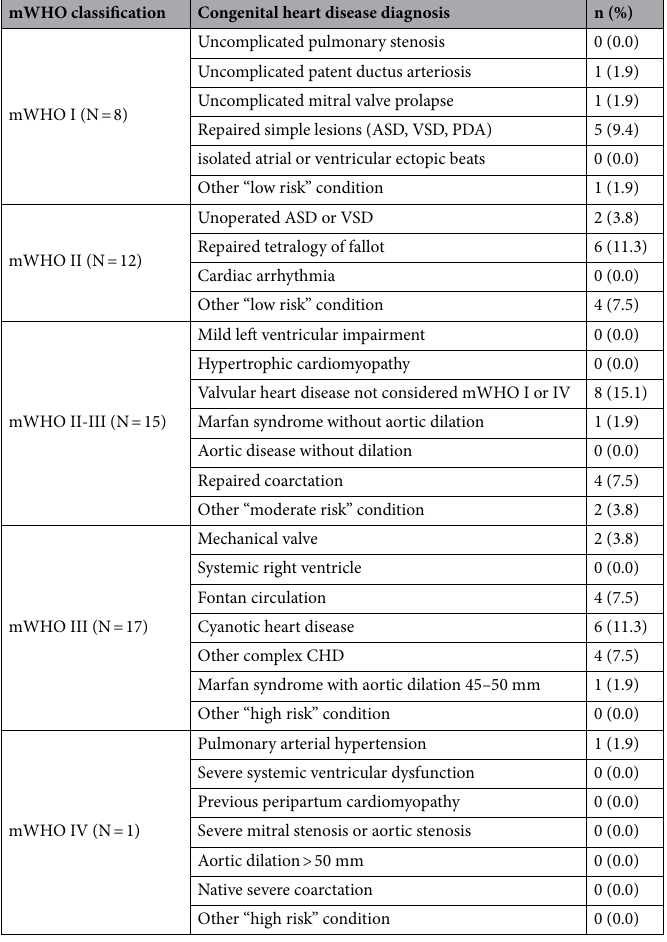
Table 2. Description of congenital heart disease (CHD) by mWHO classification in our total study population.